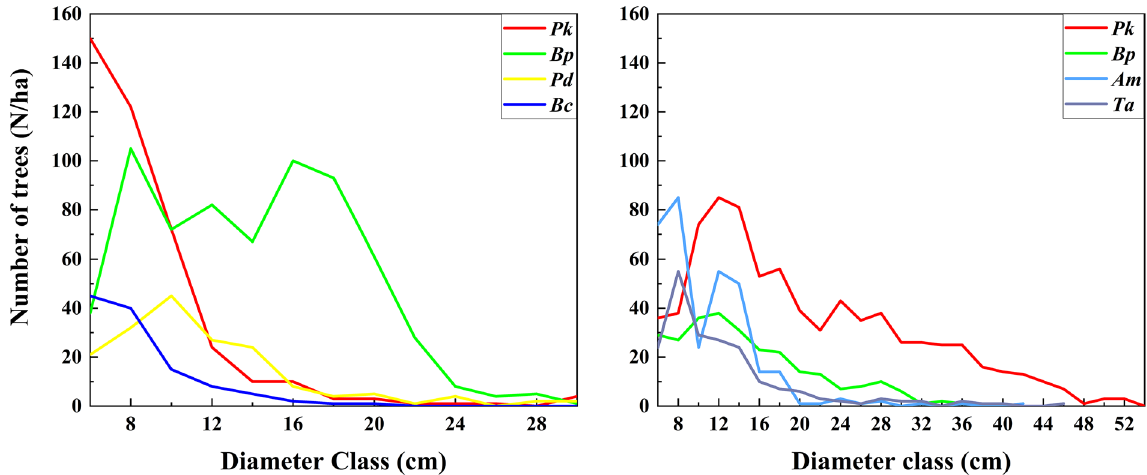
Figure 1. Diameter distributions of four dominant species trees in both disturbed (left) and undisturbed (right) plots. Red color represents Pinus koraiensis Sieb. et Zucc. ( Pk ), green color represents Betula platyphylla Suk. ( Bp ), yellow color represents Populus davidiana Dode ( Pd ), bule color represents Betula costata Trautv. ( Bc ), cyan color represents Acer mono Maxim. ( Am ), and purple color represents Tilia amurensis Rupr. ( Ta ). The color in the following figure is the same meaning.